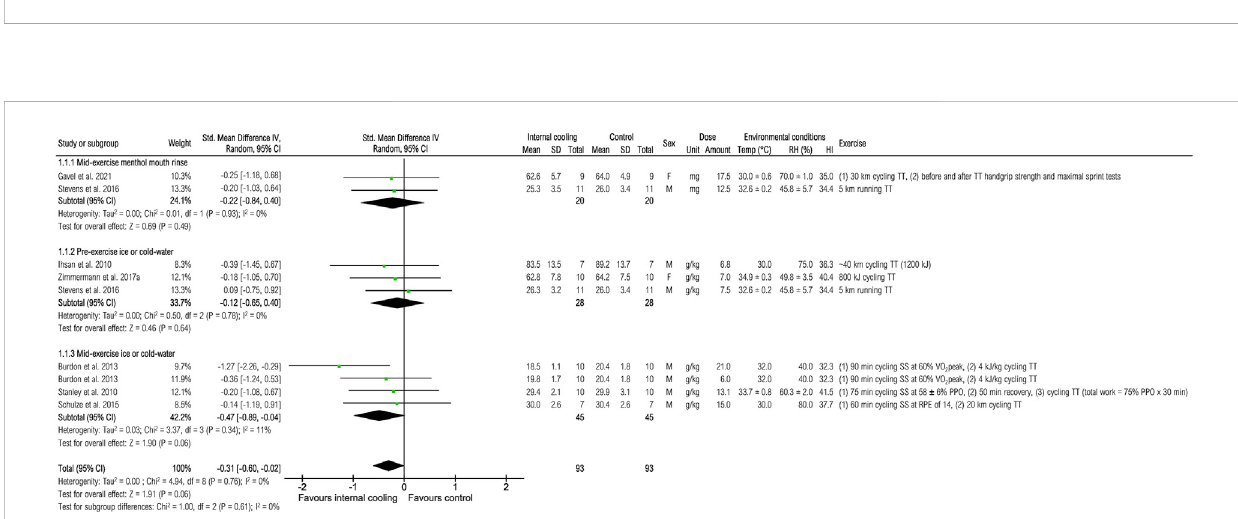
FIGURE 1 Overview of the selection process of the included studies for this review. n indicates the number of studies. 1 Total number differs from the sum of subscores as several studies reported multiple outcomes.